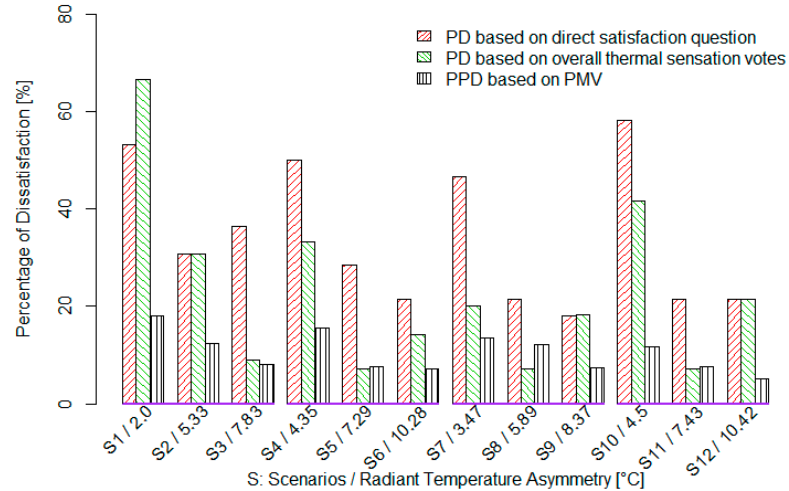
Figure 11. Comparison between the two methods for calculating the percentage of dissatisfied (PD) with respect to different scenarios, and the reference PPD values obtained using PPD-PMV equation given by Fanger and ASHRAE-55 [7,33]. The red bars are based on the direct question about overall satisfaction; whereas, the middle green bars present the PD for the method suggested by Fanger based on the overall thermal sensation votes. S1–S12 are the scenarios stated in Table 3.